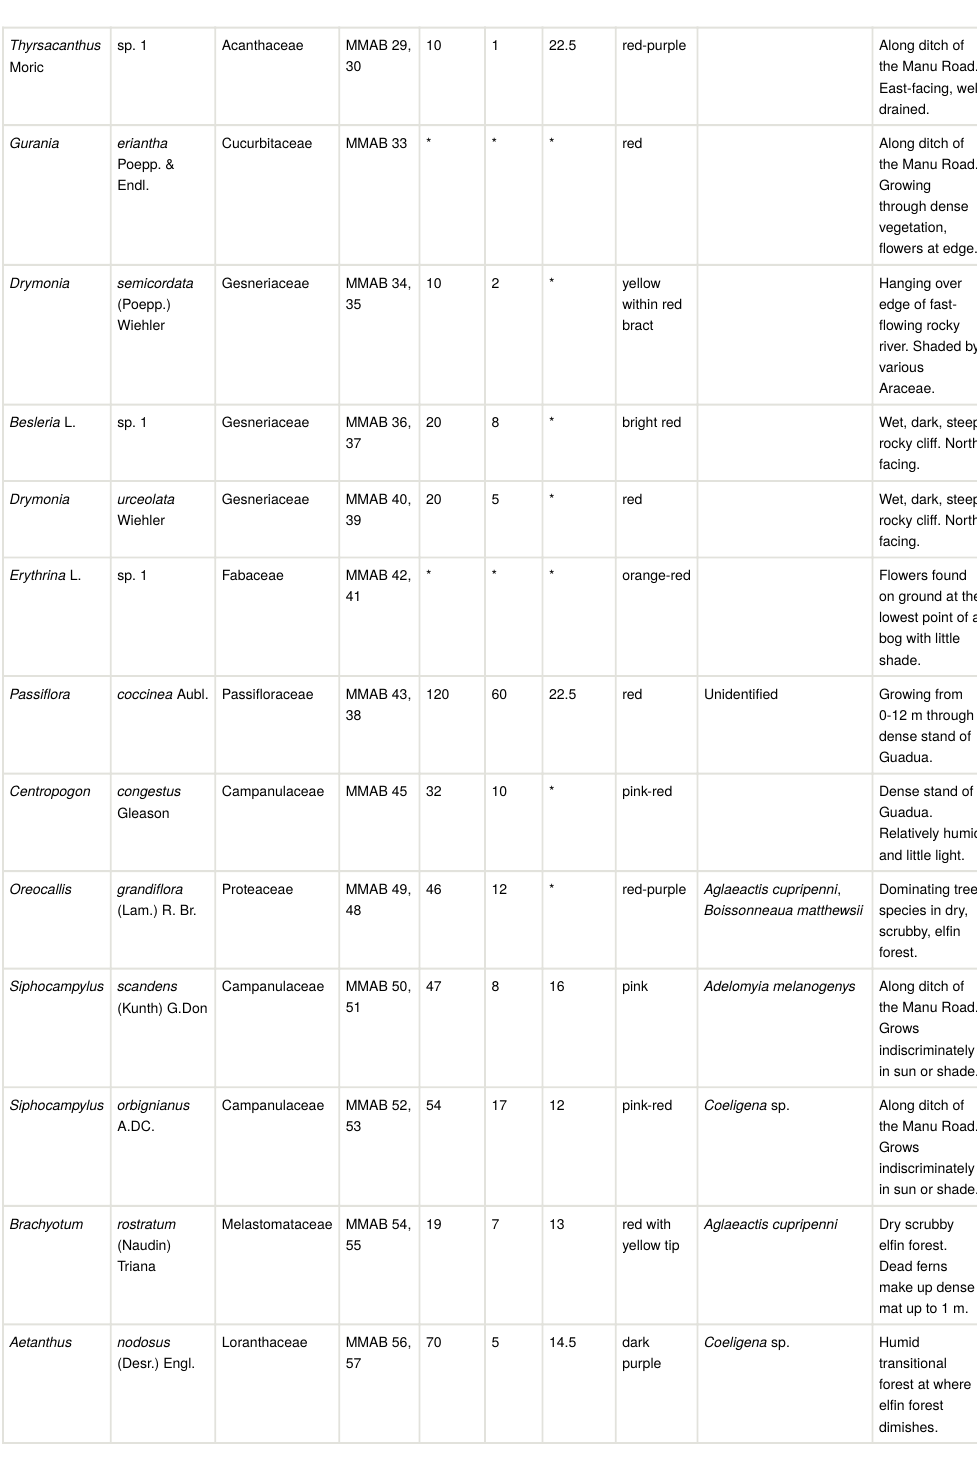
vegetation, fl owers at edge. Hanging over edge of fast- fl owing rocky river. Shaded by various Araceae. rocky cli ff . North facing. rocky cli ff . North facing. on ground at the lowest point of a bog with little shade. 0-12 m through dense stand of Guadua. Guadua. Relatively humid and little light. Dominating tree species in dry, scrubby, el fi n forest. the Manu Road. Grows indiscriminately in sun or shade. the Manu Road. Grows indiscriminately in sun or shade. Dry scrubby el fi n forest. Dead ferns make up dense mat up to 1 m. transitional forest at where el fi n forest